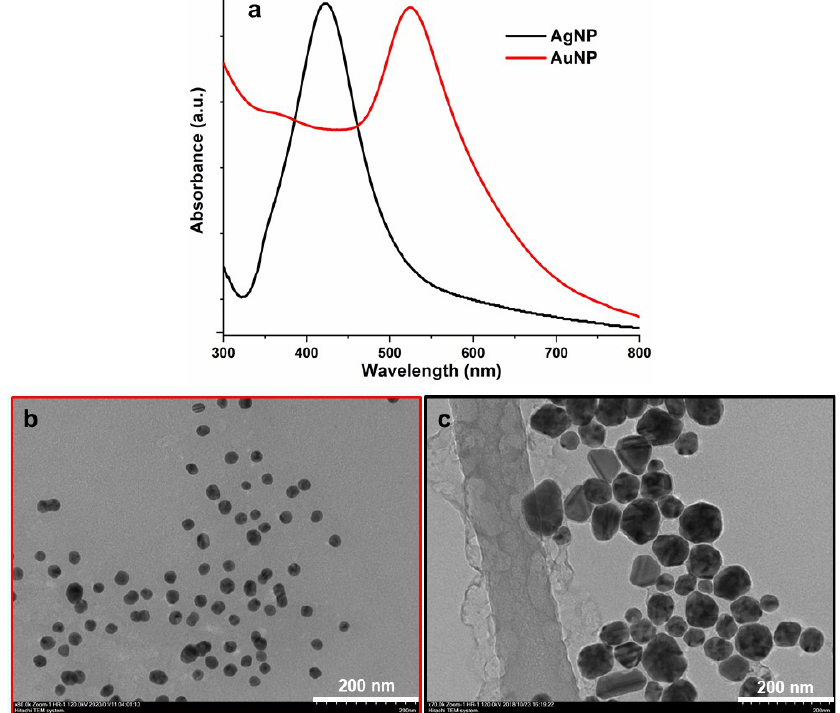
Figure 1. UV-Vis absorption spectra ( a ) and representative TEM images of gold NPs (AuNPs) ( b ), and AgNPs ( c ).